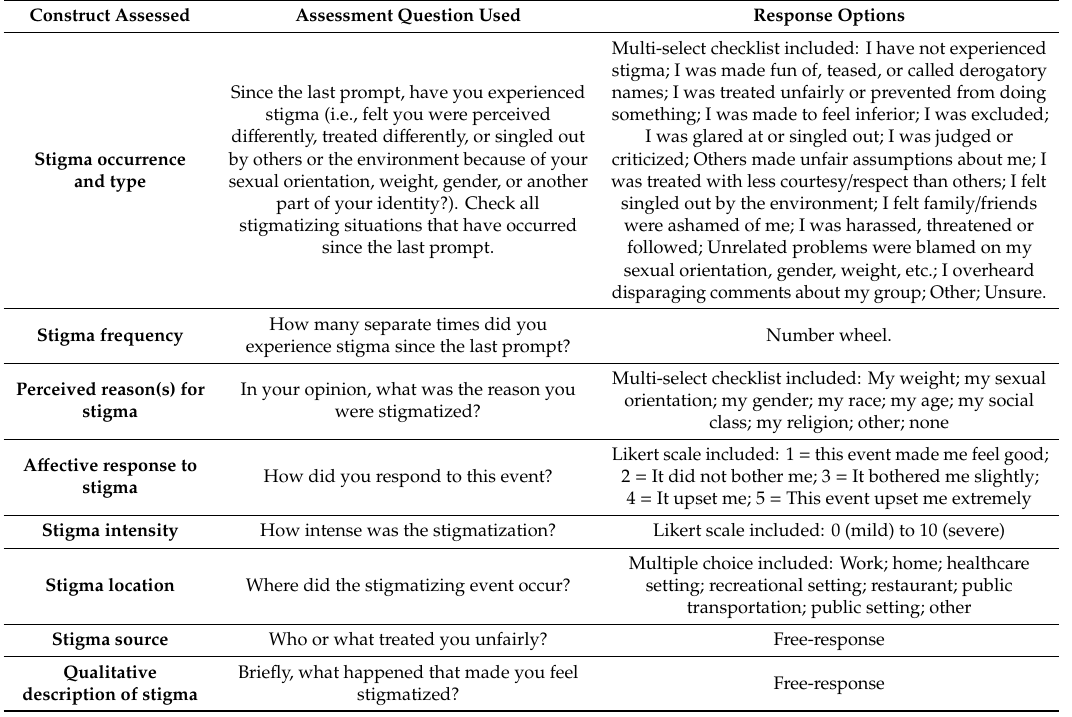
Table 1. Items used to assess momentary stigma events in daily